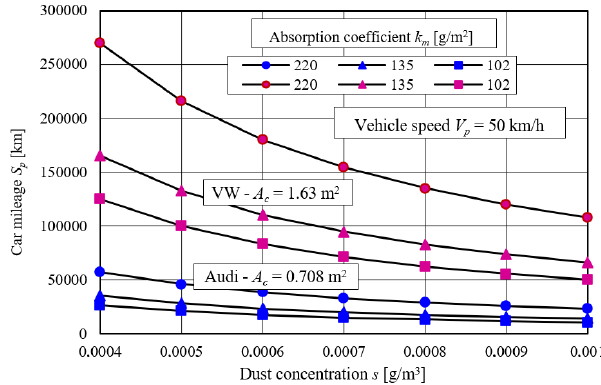
Fig. 15. Vehicle mileage until the filter reaches the permissible resistance depending on air dust concentration and various dust absorption coeffi- cients of the filter